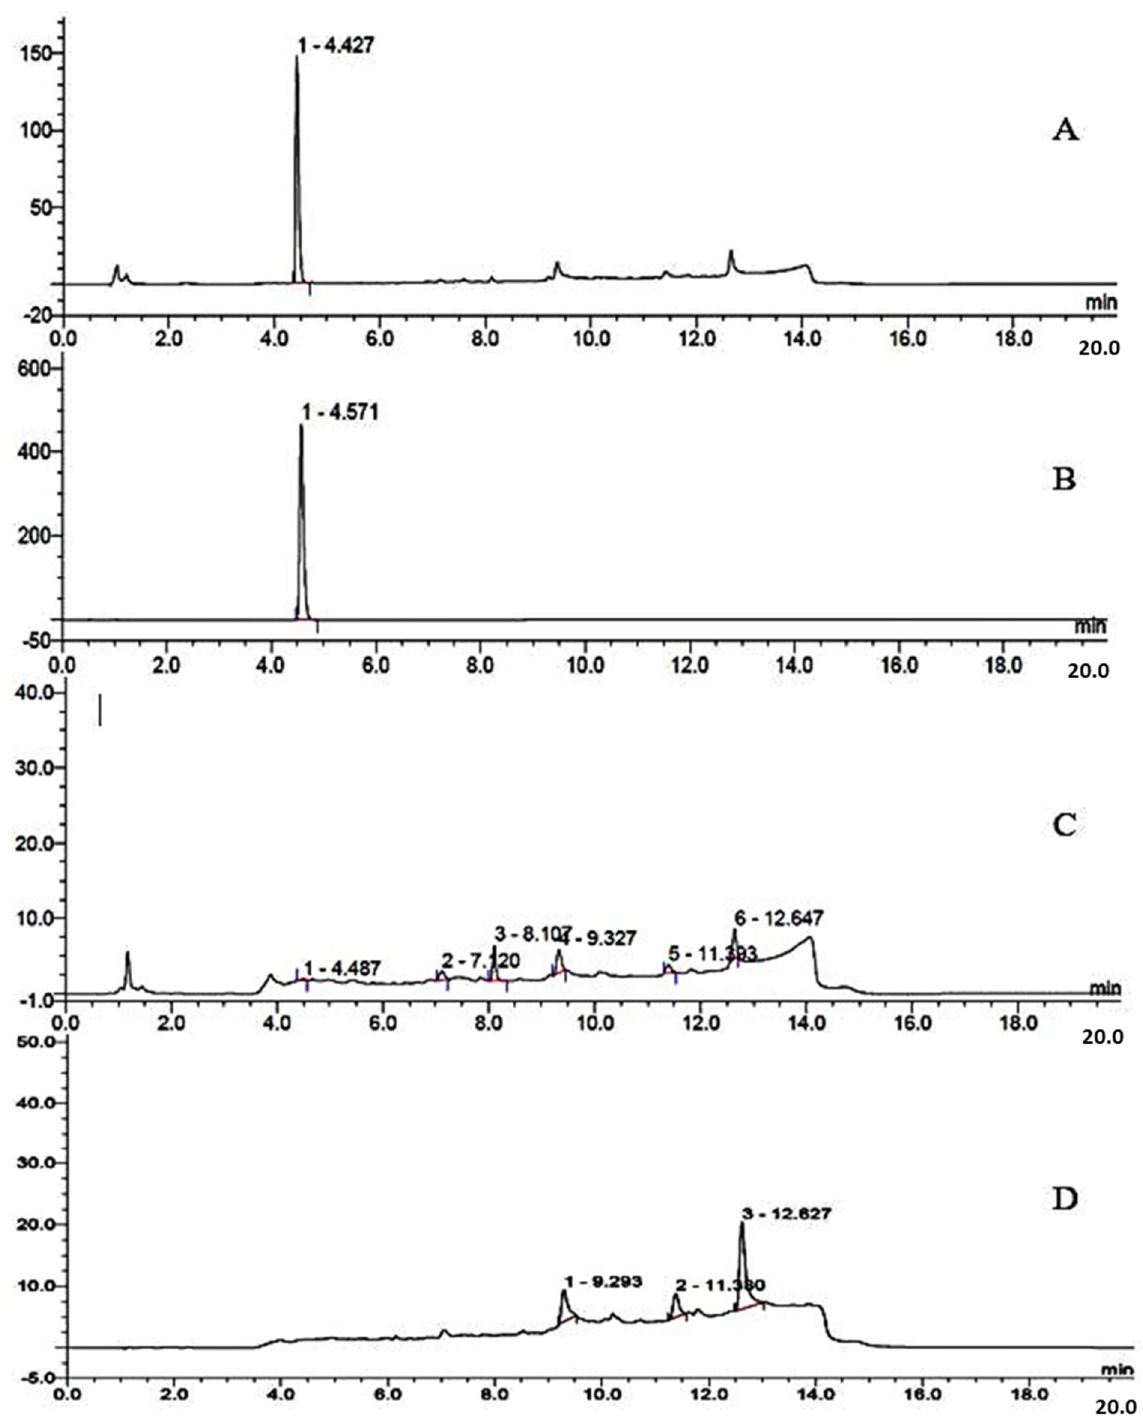
Figure 3. Quality control of 6- L -[ 18 F]FMT: ( A ) 6- DL -FMT, UV trace ( λ = 254 nm); ( B ) 6- L -[ 18 F]FMT, radioactivity trace; ( C ) 6- L -[ 18 F]FMT, UV trace ( λ = 254 nm); ( D ) injection of the starting eluent (2% MeCN (0.1% TFA)), UV trace ( λ = 254 nm); HPLC conditions: column: XBridge ® C18 5 µ m, 150 × 4.6 mm (Waters, Millford, CT, USA); gradient: 0–2 min: 2% MeCN (0.1% TFA), 2–13 min: 2–90% MeCN (0.1% TFA); flow rate: 2.0 mL/min; R t of 6- L -[ 18 F]FMT: 4.6 min; ( D ) blank UV chromatogram at 254 nm. Please, notice that the diffuse peak at 3.8–14.0 min and peaks at 3.9; 4.5; 7.2; 8.1; 9.3; 11.4; and 12.6 min (UV 254 nm) are also visible if the starting eluent is injected under the same chromatographic